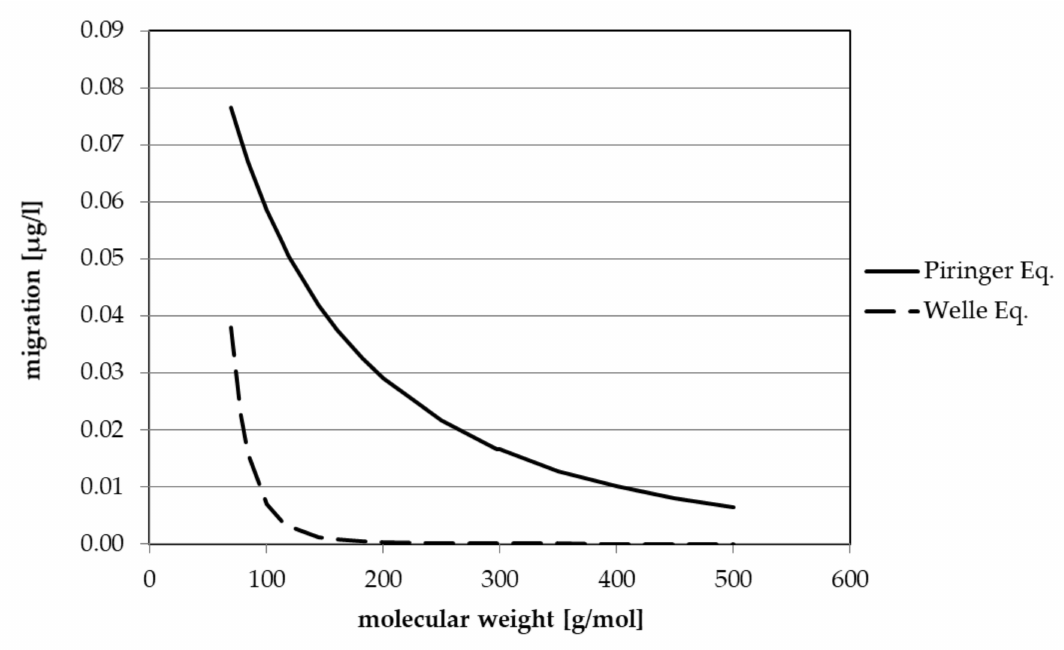
Figure 1. Correlation between the migration and the molecular weight calculated from predicted di ff usion coe ffi cients (PIRINGER Eq. [25–27] and WELLE Eq. [8] with an concentration of 10 µ g / kg in the PET non-food input with 5% non-food content and a cleaning e ffi ciency of 90% after storage for 365 day at 25 ◦ C (EU